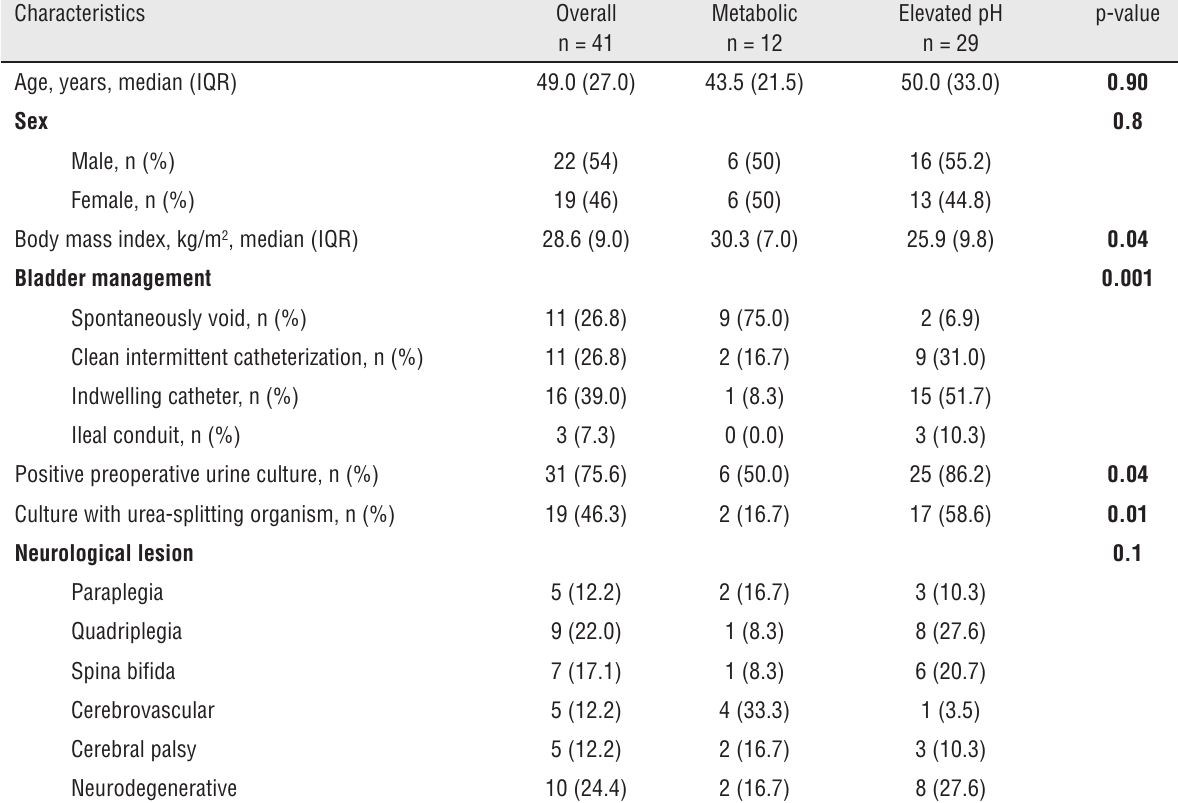
Table 1 - Demographic and clinical characteristics overall and by primary calculus classification.